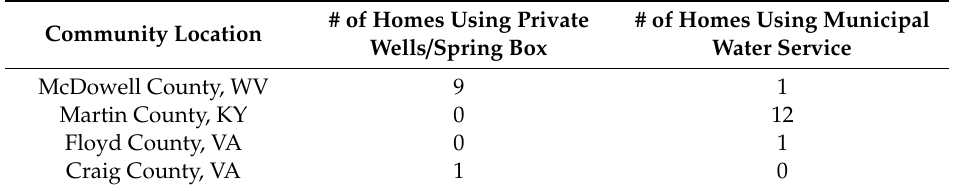
Table 1. Distribution of homes on private and municipal drinking water treatment systems in each community (n =